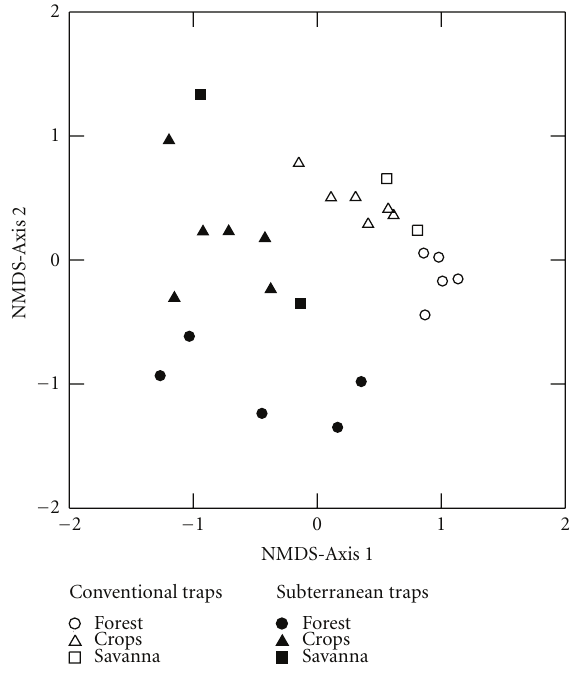
Figure 3: Nonmetric multidimensional scaling (NMDS) ordina- tion of transects placed in di ff erent habitats based on the compo- sition of ant species captured in subterranean or in conventional pitfall